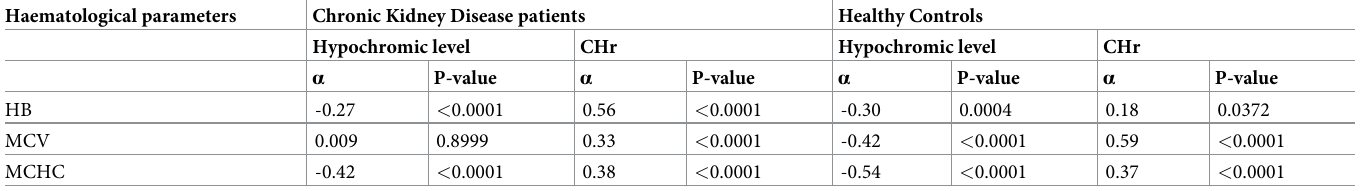
Table 3. Correlation of reticulocyte haemoglobin content and percentage hypochromic red cells with other haematological parameters among CKD participants and healthy controls. Haematological